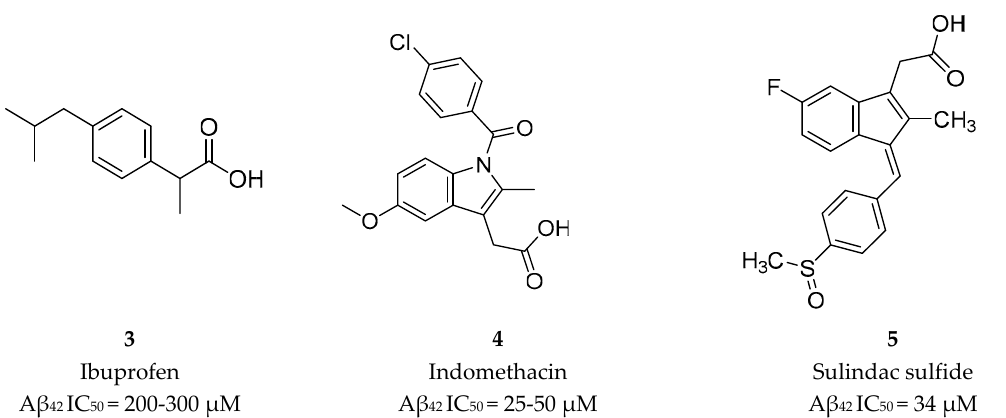
Figure 7. NSAIDs GSMs 3 – 5 and respective A β 42 half-maximal inhibitory concentration (IC 50 ) values [44].